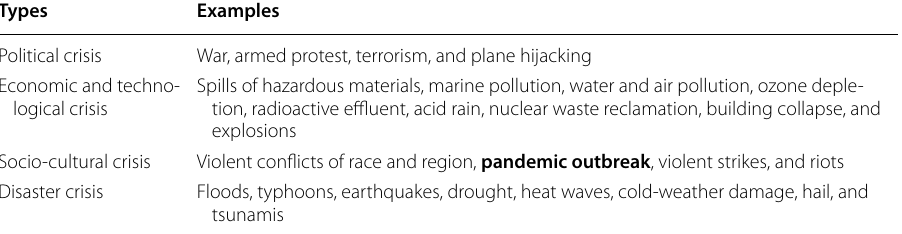
Table 1 Types of social crises (Lee, 1998, p. 4 [see Table 2–1 of the original source]) Types